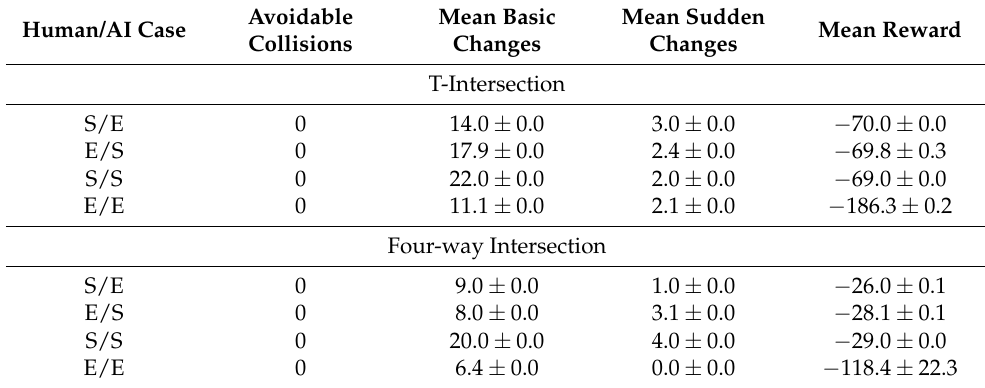
Table 11. Human: light, AI: sensor and mask. Test results for manager performance and behavior.